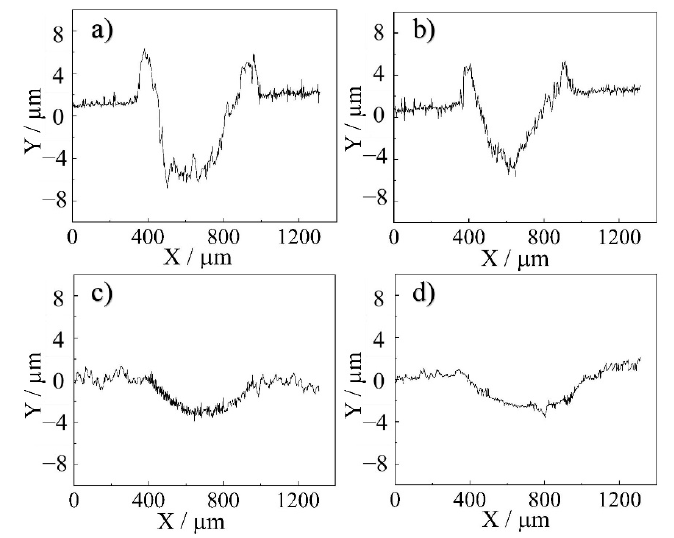
Figure 9. 2D cross-sectional surface profile of the wear track: ( a ) S1, ( b ) S2, ( c ) C1, ( d ) C2.